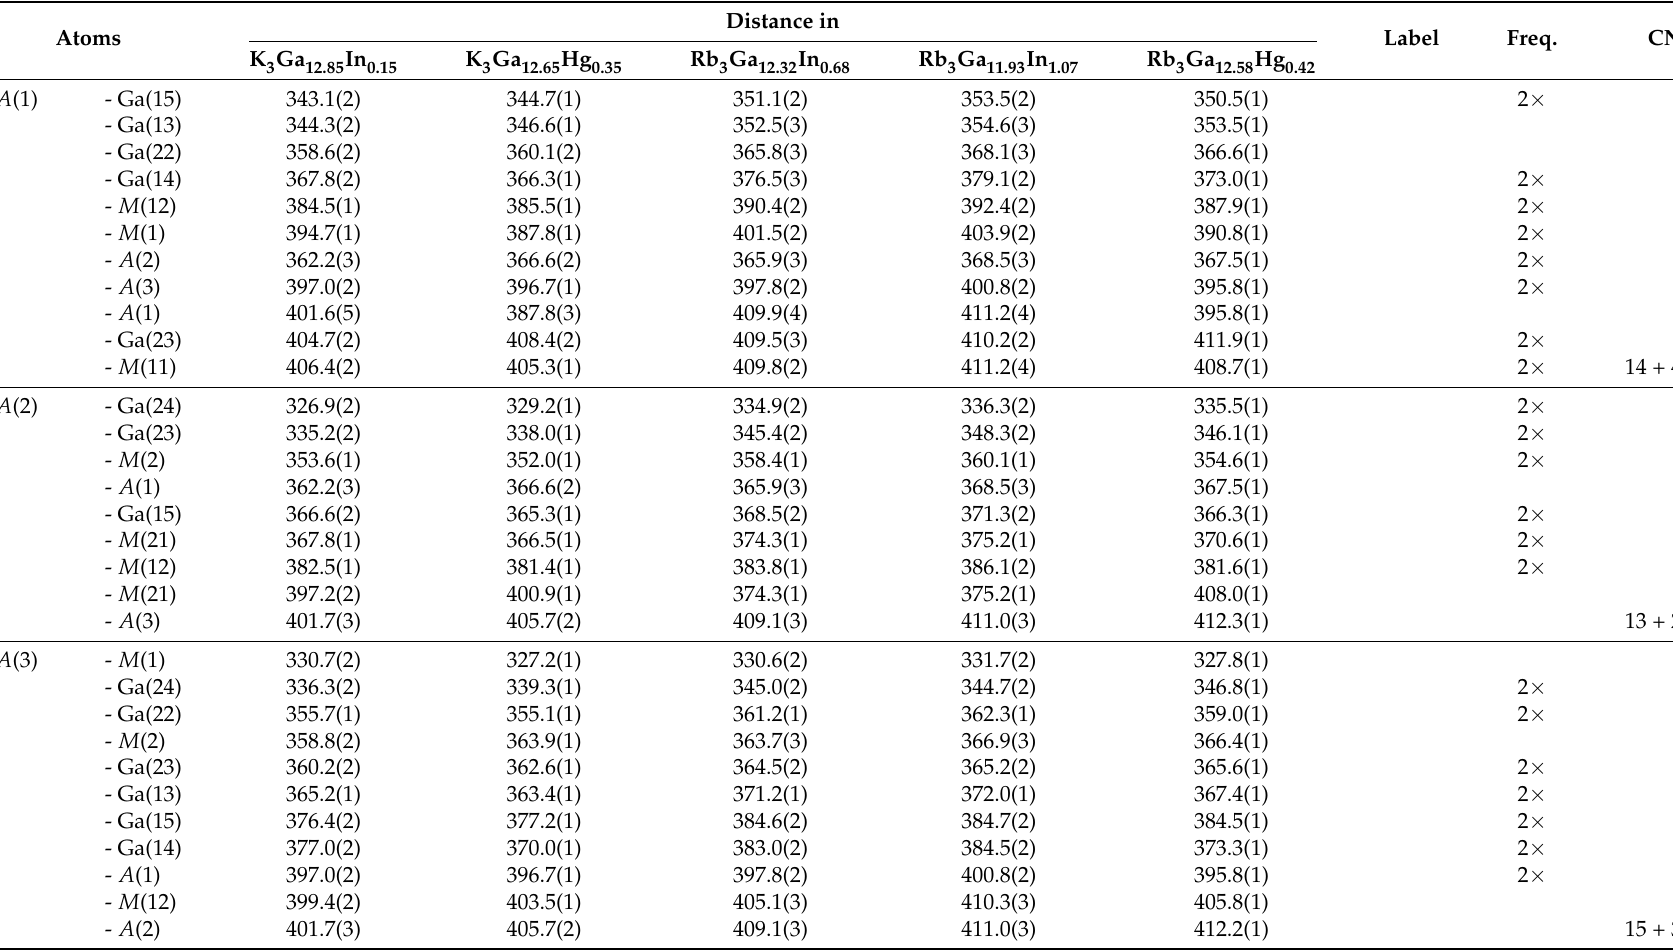
Table 8. Selected interatomic distances/pm of the K and Rb atoms (top), as well as M (1) and M (2) (bottom) in the crystal structures of compounds forming the K Ga -type structure ( intra -cluster bonds; cf. Table 3 13